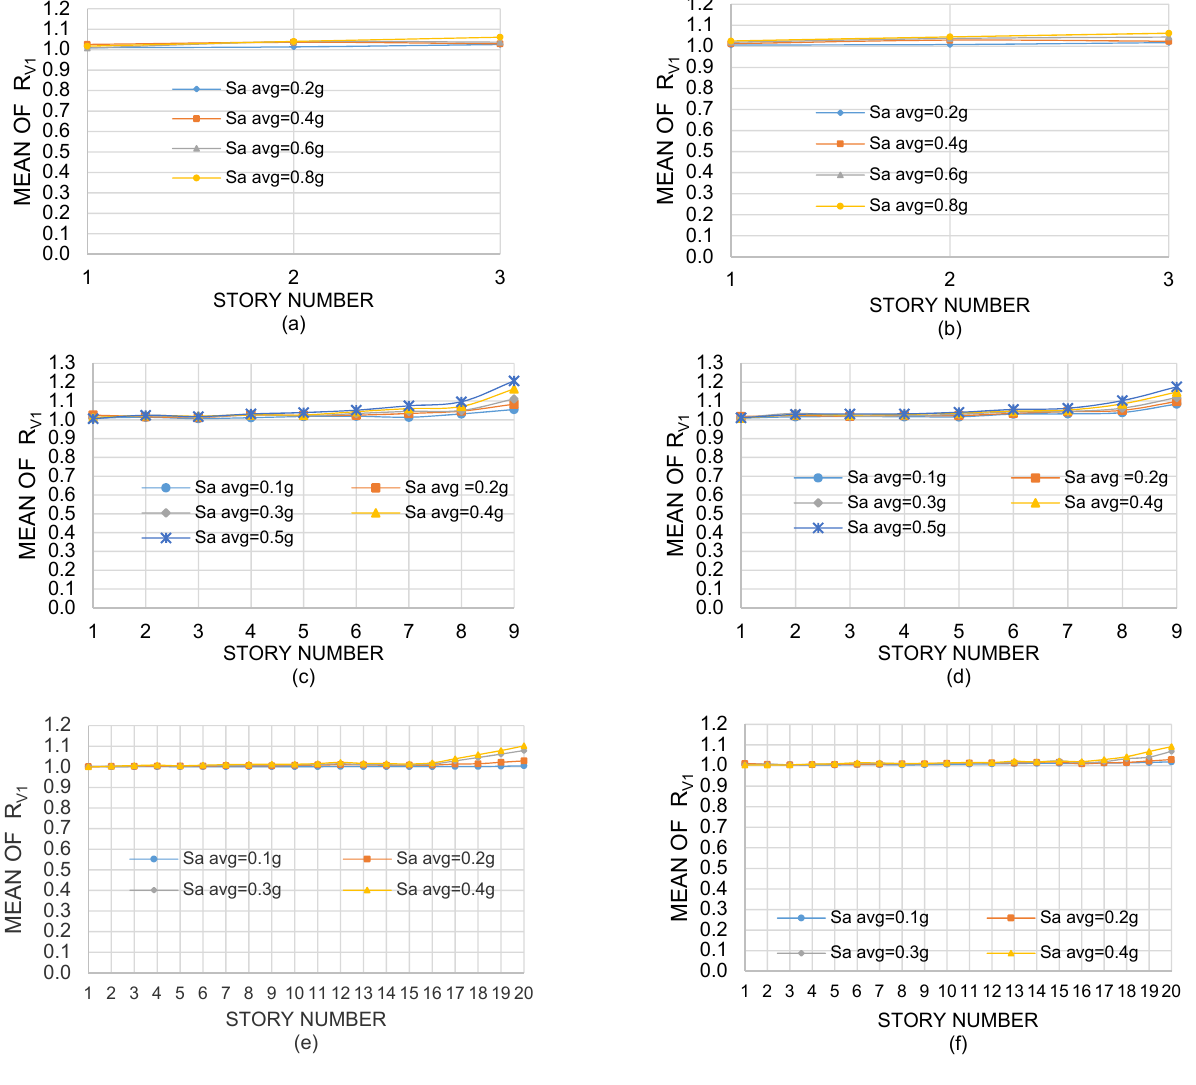
Figure 10. Mean values of R V 1 ; ( a , b ) , NS - EW direction, respectively, Model 1; ( c , d ) , NS - EW direction, respectively, Model 2; ( e , f ) , NS - EW direction, respectively, Model 3.